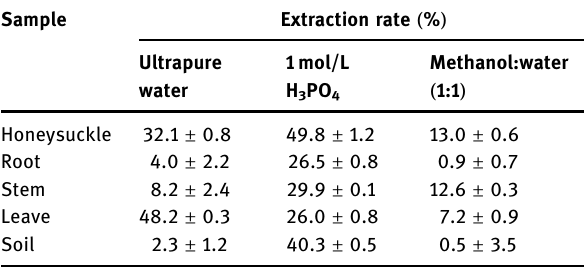
Extraction rate = the total amount of As digested by the extracted